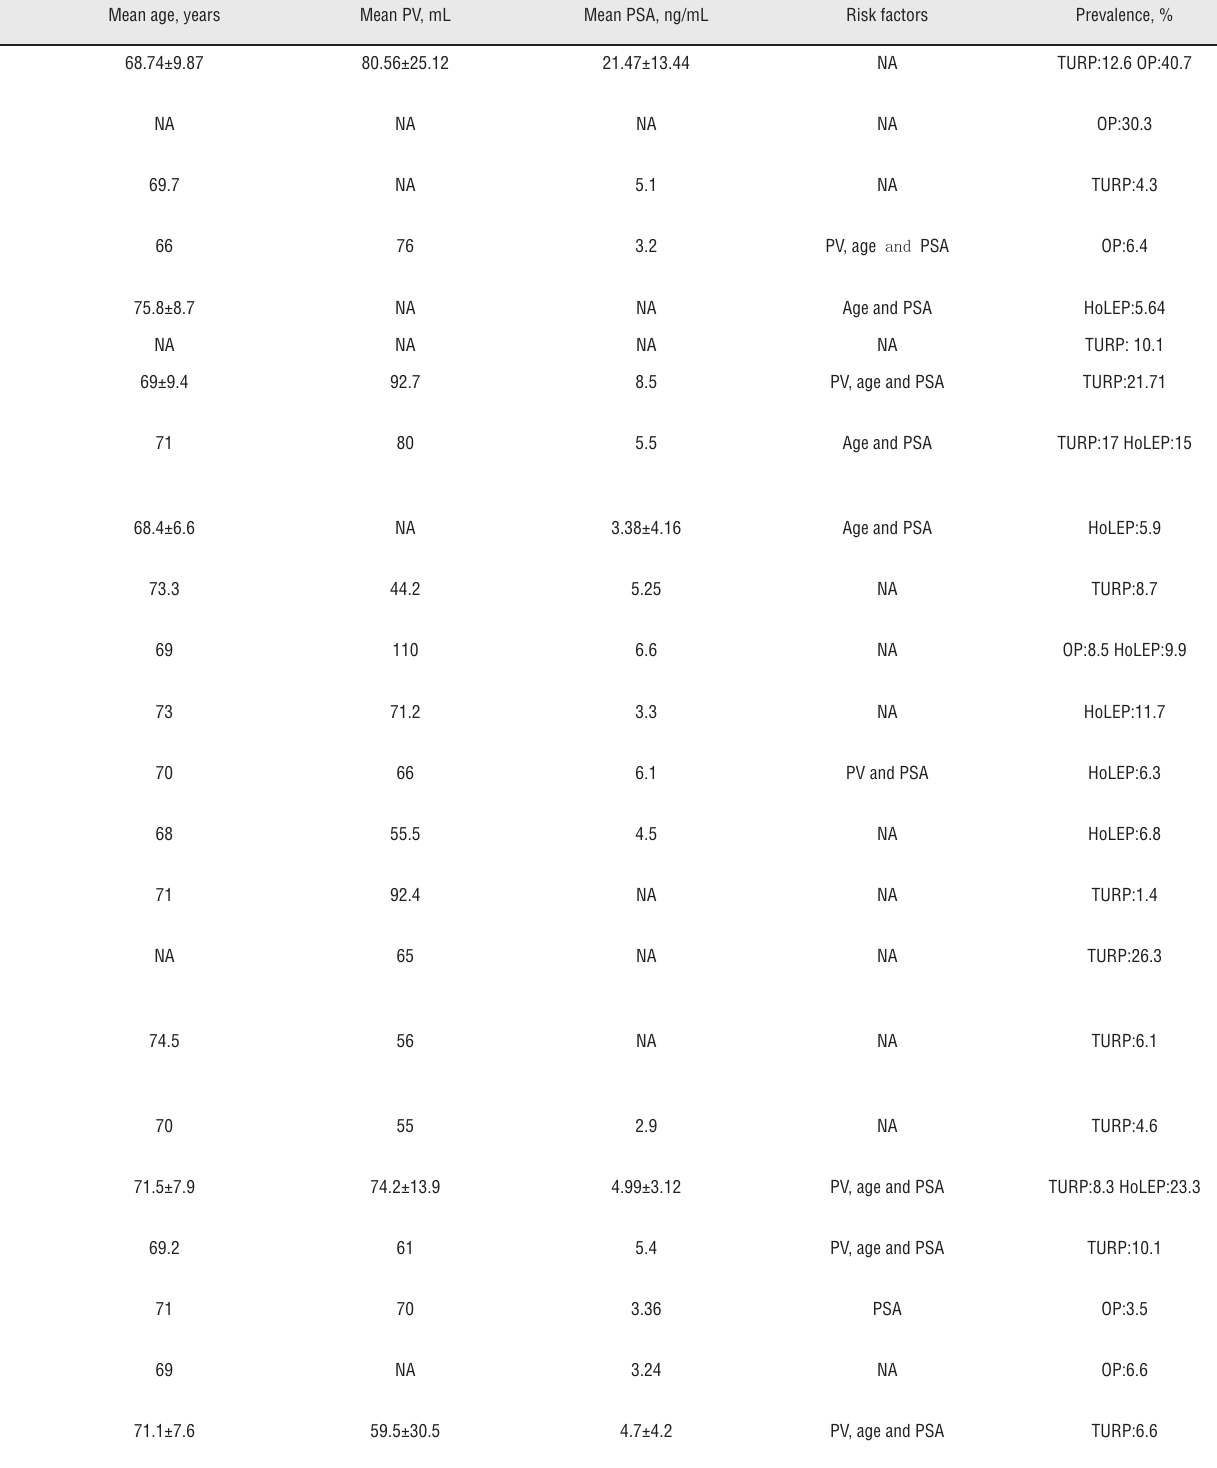
Table 1 - Characteristics of the included